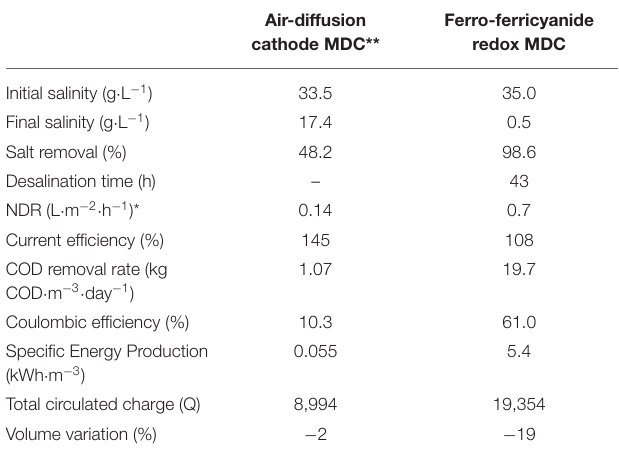
TABLE 3 | Initial and final salinity, salt removal, desalination time, current efficiency, nominal desalination rate, COD removal rate, anode coulombic efficiency, specific